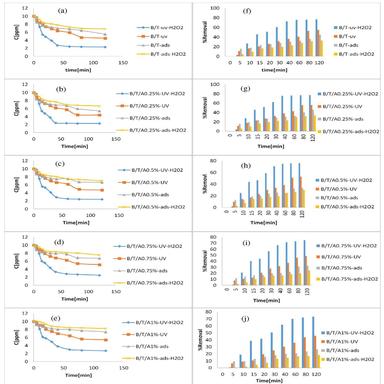
Dye removal kinetic results for DR-80 by hydrogen peroxide-assisted photocatalytic degradation, UV photocatalytic degradation, catalytic hydrogen peroxide oxidation, and adsorption processes, respectively (10 mg/L concentration, 0.03 g nanocomposite, 120 min).